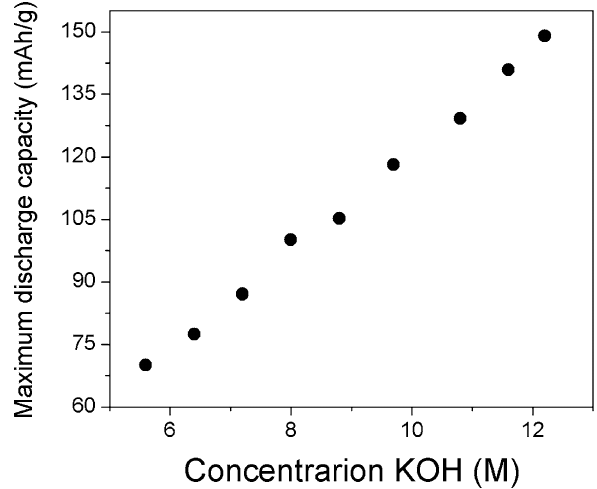
Fig. 4 a Typical charge curves (at 125 mA/g) and b discharge curves (at 31.25 mA/g) of LaFeO 3 at various temperatures in a 7 M KOH solution. Data adapted from [78]